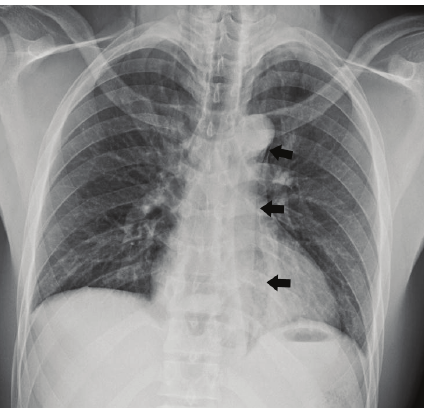
Figure 1: Chest X-ray displaying pneumomediastinum (indicated by black arrows) and left-sided pleural effusion.